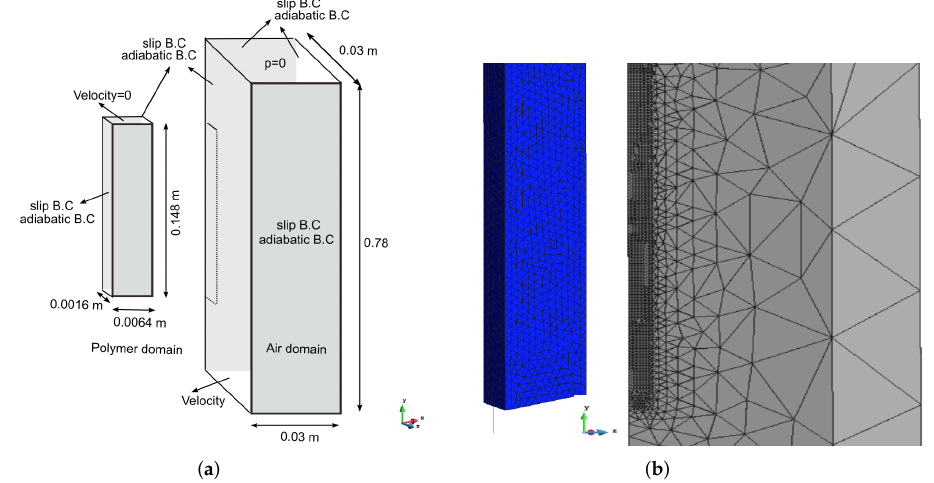
Figure 5. Problem definition. ( a ) Computational domains with boundary conditions. ( b ) Meshes of the polymer and the air